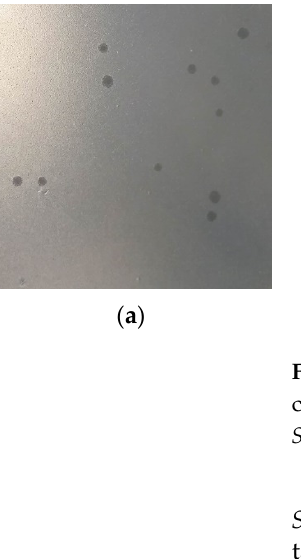
Table 2. Efficiency of plating (EOP) of phage Ps15 on different bacterial hosts expressed as the ratio of the phage titre of the tested strains and the titre of the propagating host strain (2.1 × 10 8 PFU/mL).